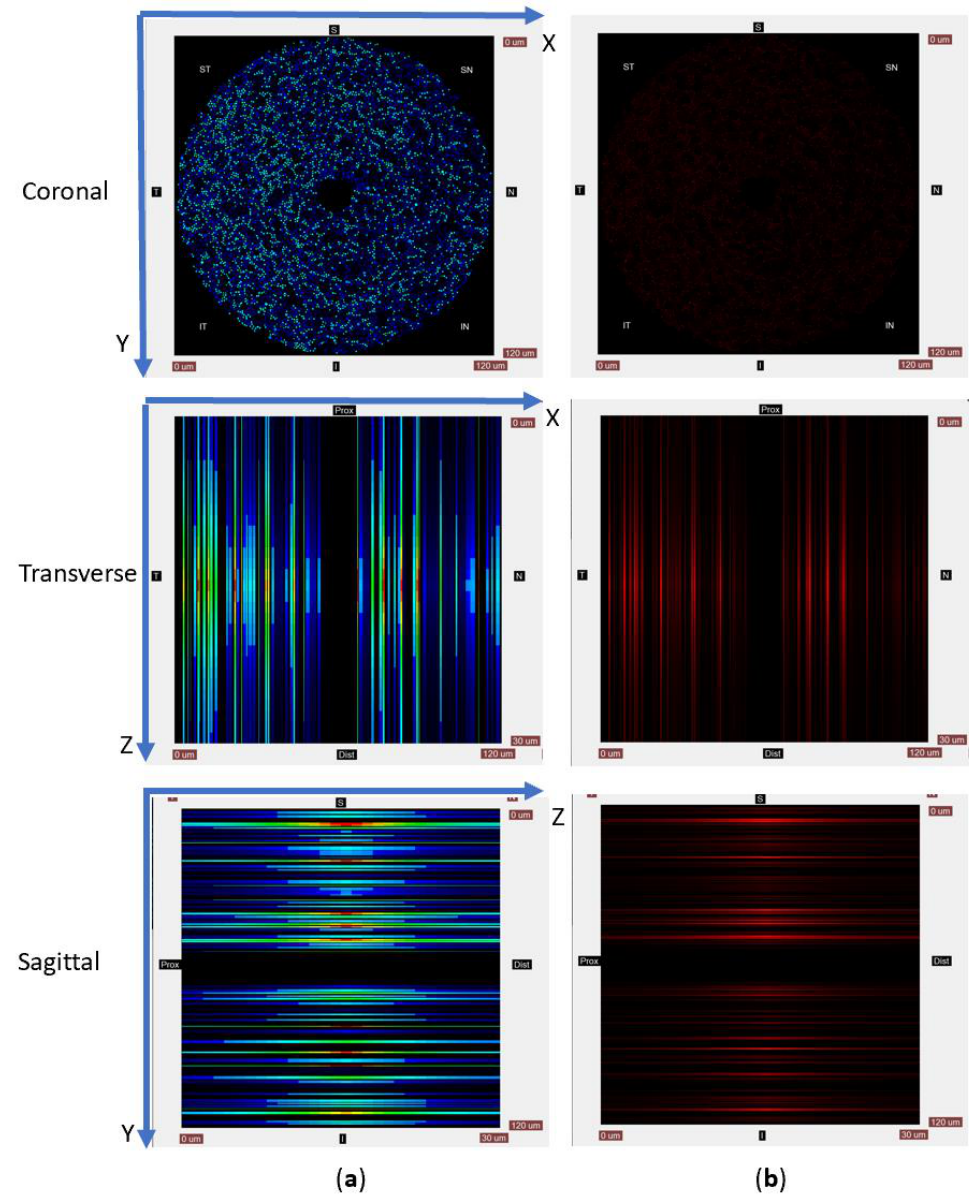
Figure 3. ROS concentrations can be visualized using a heatmap ( a ) or single-color intensity ( b ). Sample physical dimensions are mapped to the same number of pixels, resulting in square images even if the sample cut would be a rectangle. In all pictures, black denotes a zero concentration of species. The top of the transverse images represents the model’s proximal side, while the bottom of the image shows the model’s distal side. The transverse view’s left side shows the temporal (T) octant, while the right side of the image corresponds to the nasal (N) octant. In the sagittal views, the picture’s left shows the proximal plane, while the picture’s right shows the distal part. The image top corresponds to the superior (S) octant and the bottom of the image to the inferior (I) octant. Superimposed on the sample is a Cartesian system of coordinates. The coordinate system origin is in the left corner of the coronal plane. The X-axis runs left to right along the top line of the coronal cut, while the Y-axis runs from top to bottom in the same view. Thus, the coronal plane cut displays the XY plane. The Z-axis runs along the proximal to distal direction, with the origin on the axis at the proximal side.